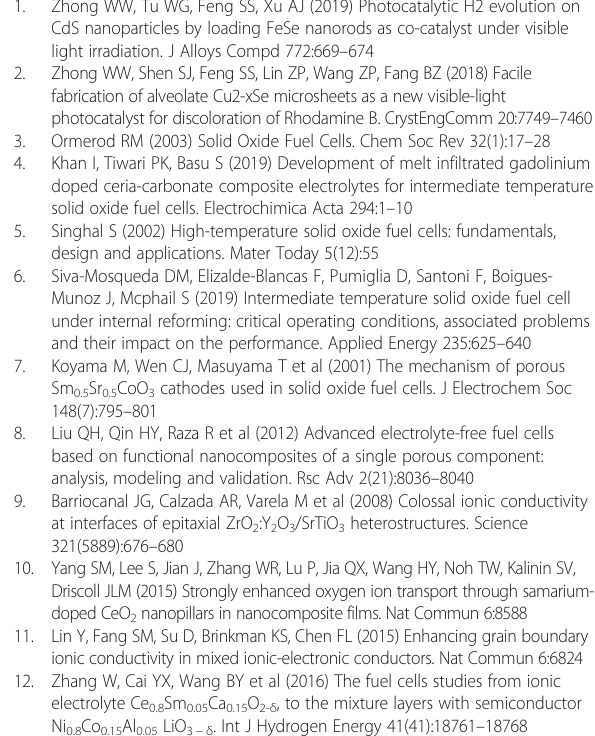
Additional file 1: Figure S1. The EDS mapping of 600 °C sintered pellet cross-section. Figure S2. The EDS mapping of 800 °C sintered pellet cross-section. Figure S3. The EDS mapping of 900 °C sintered pellet cross-section. Figure S4. The SEM images for pure LSCF and pure SCDC powder. Figure S5. The photo of measuring the pellet thickness by spiral micrometer. (DOC 8902 kb) Abbreviations CPE: Constant phase element; EDS: Energy-dispersive spectrometer; EFFC: Electrolyte- free fuel cell; EIS: Electrochemical impedance spectroscopy; LSCF: La 0.6 Sr 0.4 Co 0.2 Fe 0.8 O 3- δ ; LT-SOFC: Low-temperature solid oxide fuel cell; NCAL: Ni 0.8 Co 0.15 Al 0.05 LiO 2- δ ; OCV: Open circuit voltage; P max : Peak power density; R b : Buck resistance; R gb : Resistance of grain